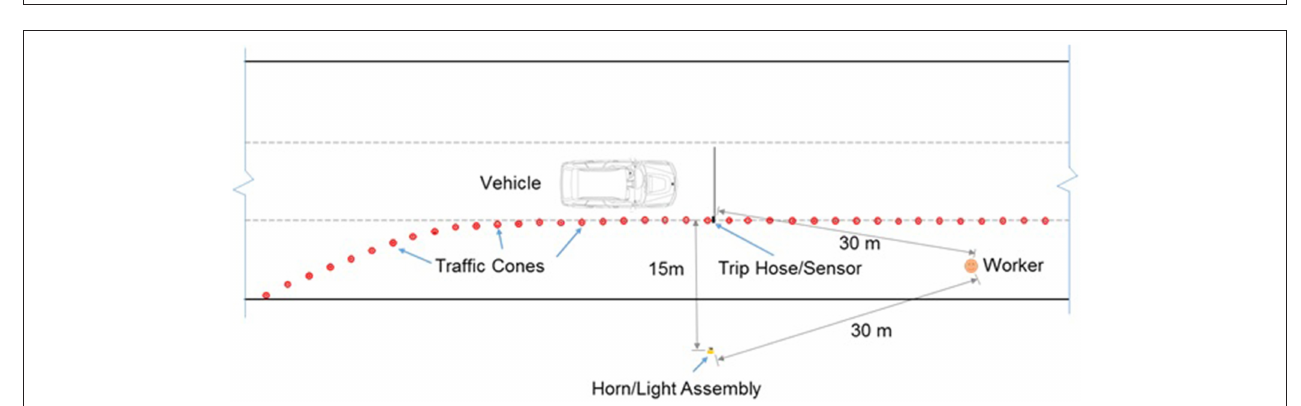
FIGURE 2 | Test bed for experimental trials.